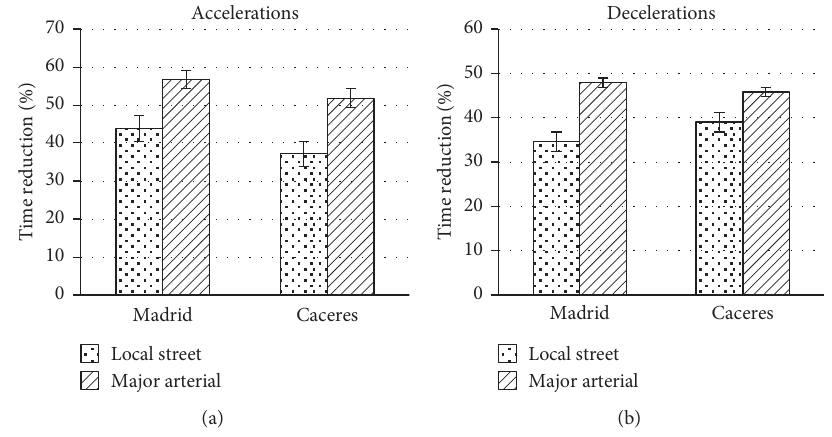
Figure 11: Impact of eco-driving in accelerations and deceleration higher than 0.83m/s 2